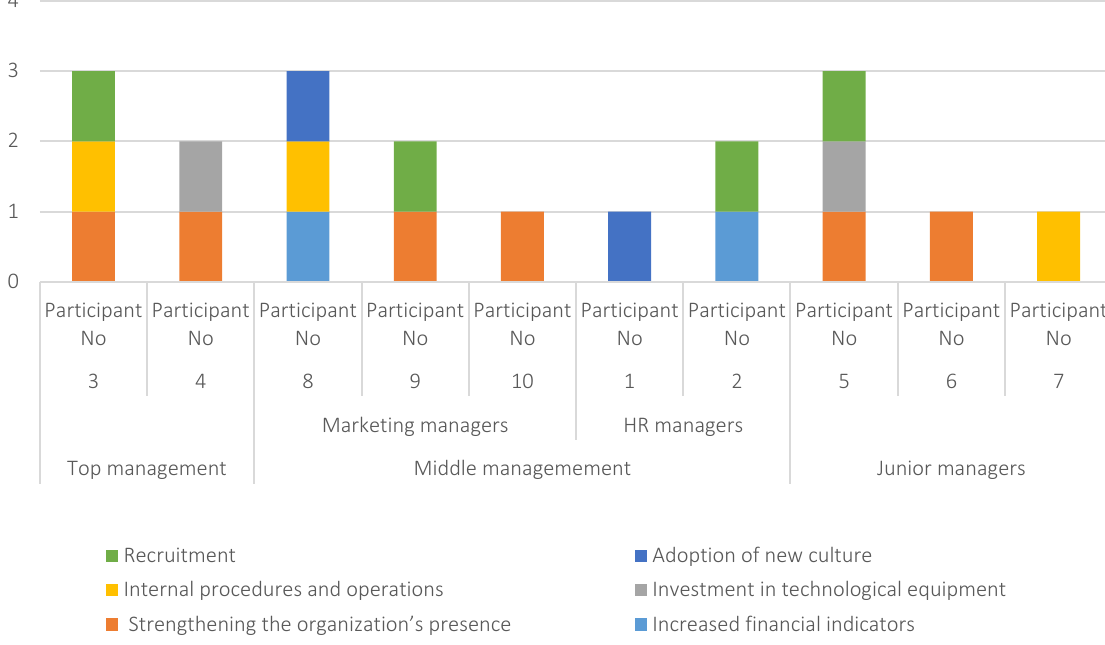
Figure 1a. Internal marketing and organization’s development/executives’ perceptions